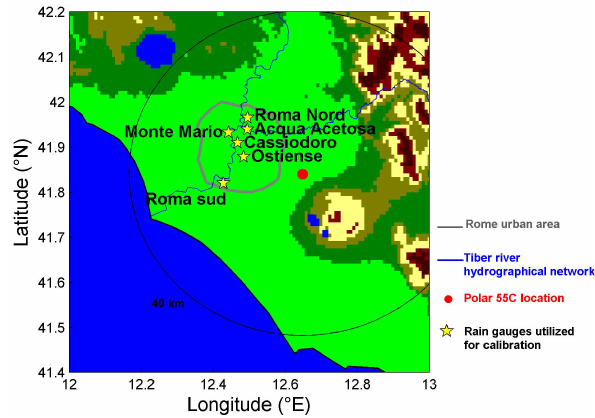
Fig. 1. Test area and rain gauge positions. Also shown are Polar 55C location, the Rome urban area and the hydrographical network of the Tiber River. Range rings are centred on Polar 55C.